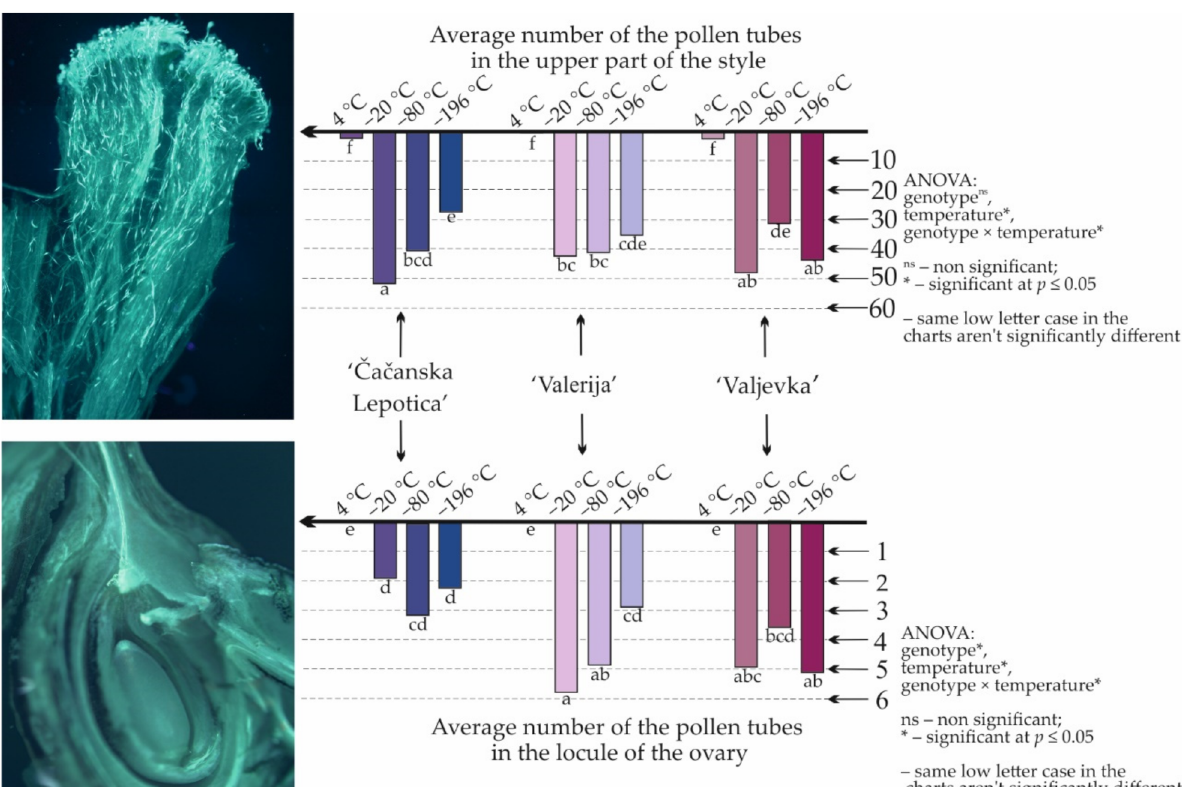
Figure 4. Average number of pollen tubes in certain parts of the pistil of ‘ ˇCaˇcanska